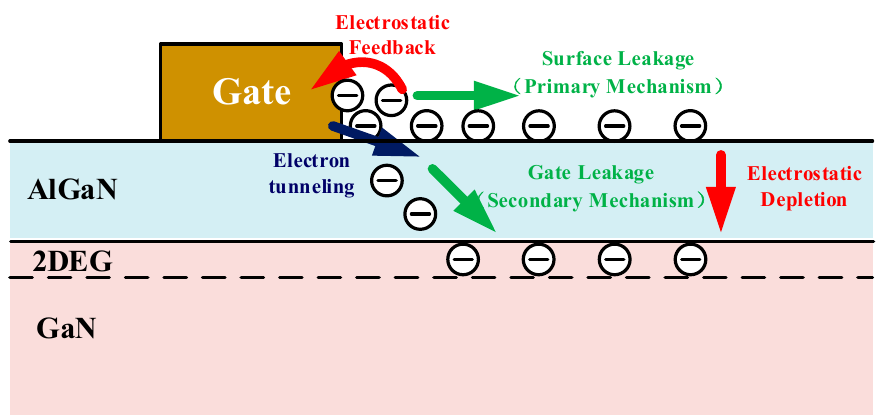
Figure 5. A cross-section of an advanced GaN HEMT structure [24].